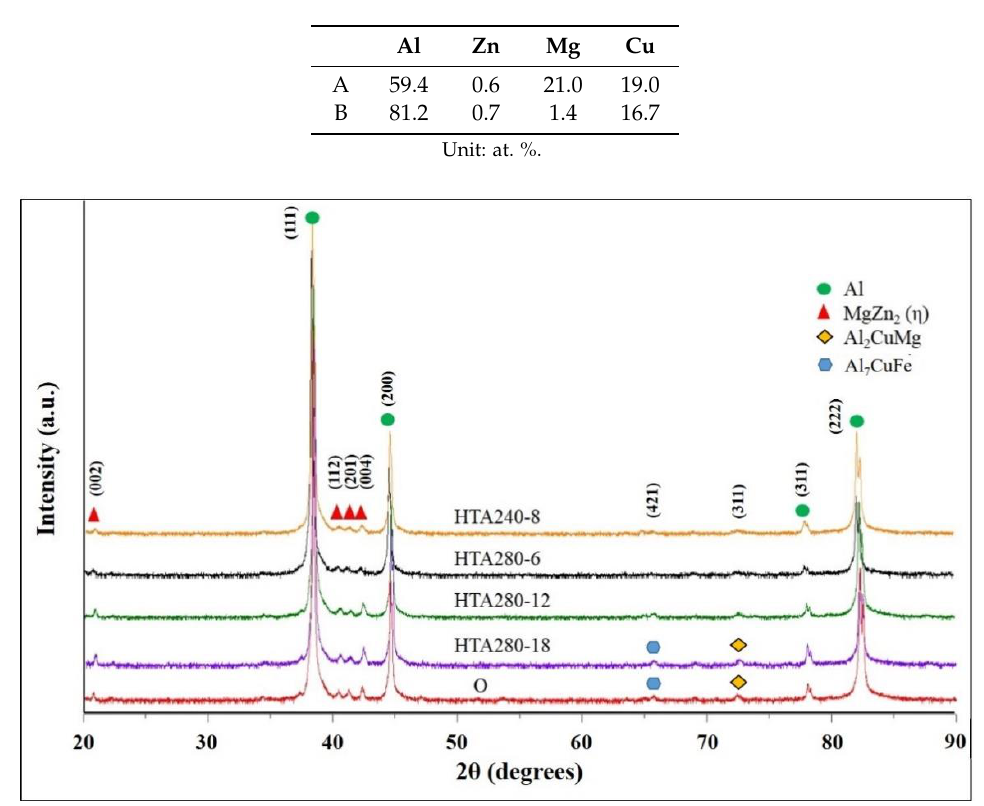
Figure 4. The morphology and the distribution of second phase particles for O specimen: ( a , b ) display various magnifications; ( c , d ) display various second phase particles in the matrix. Table 3. Energy dispersive spectrometer (EDS) data for specimens shown in Figure 4c,d.